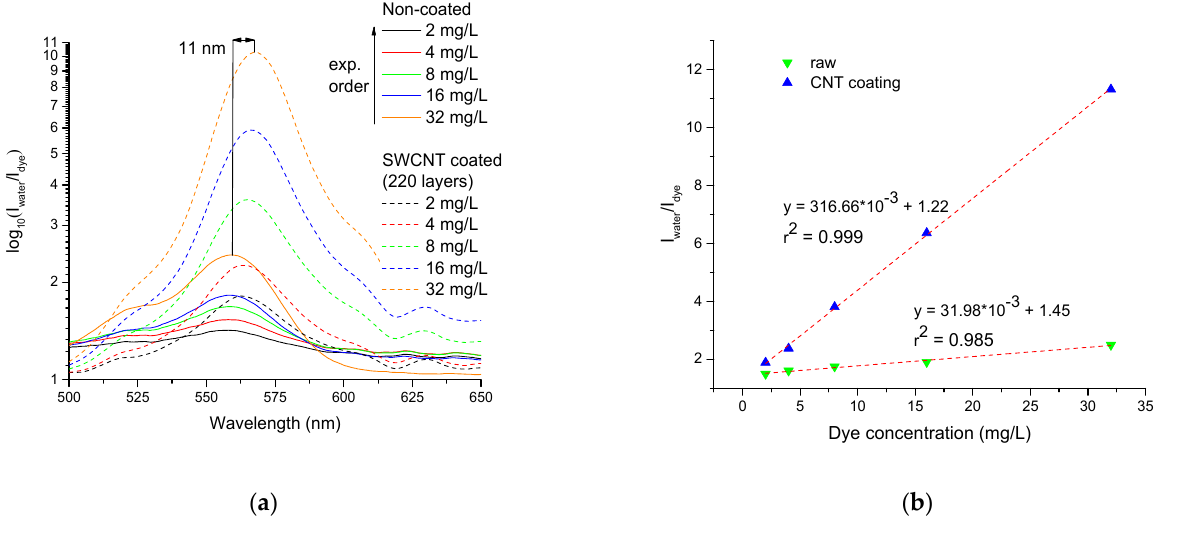
Figure 8. I water /I dye spectra of the Rhodamine B solution with concentrations of 2–32 mg/L (solid curves, before CNT deposition; dashed curves, after SWCNTs deposition); ( a ) and I water /I dye vs concentration dependences ( b ).